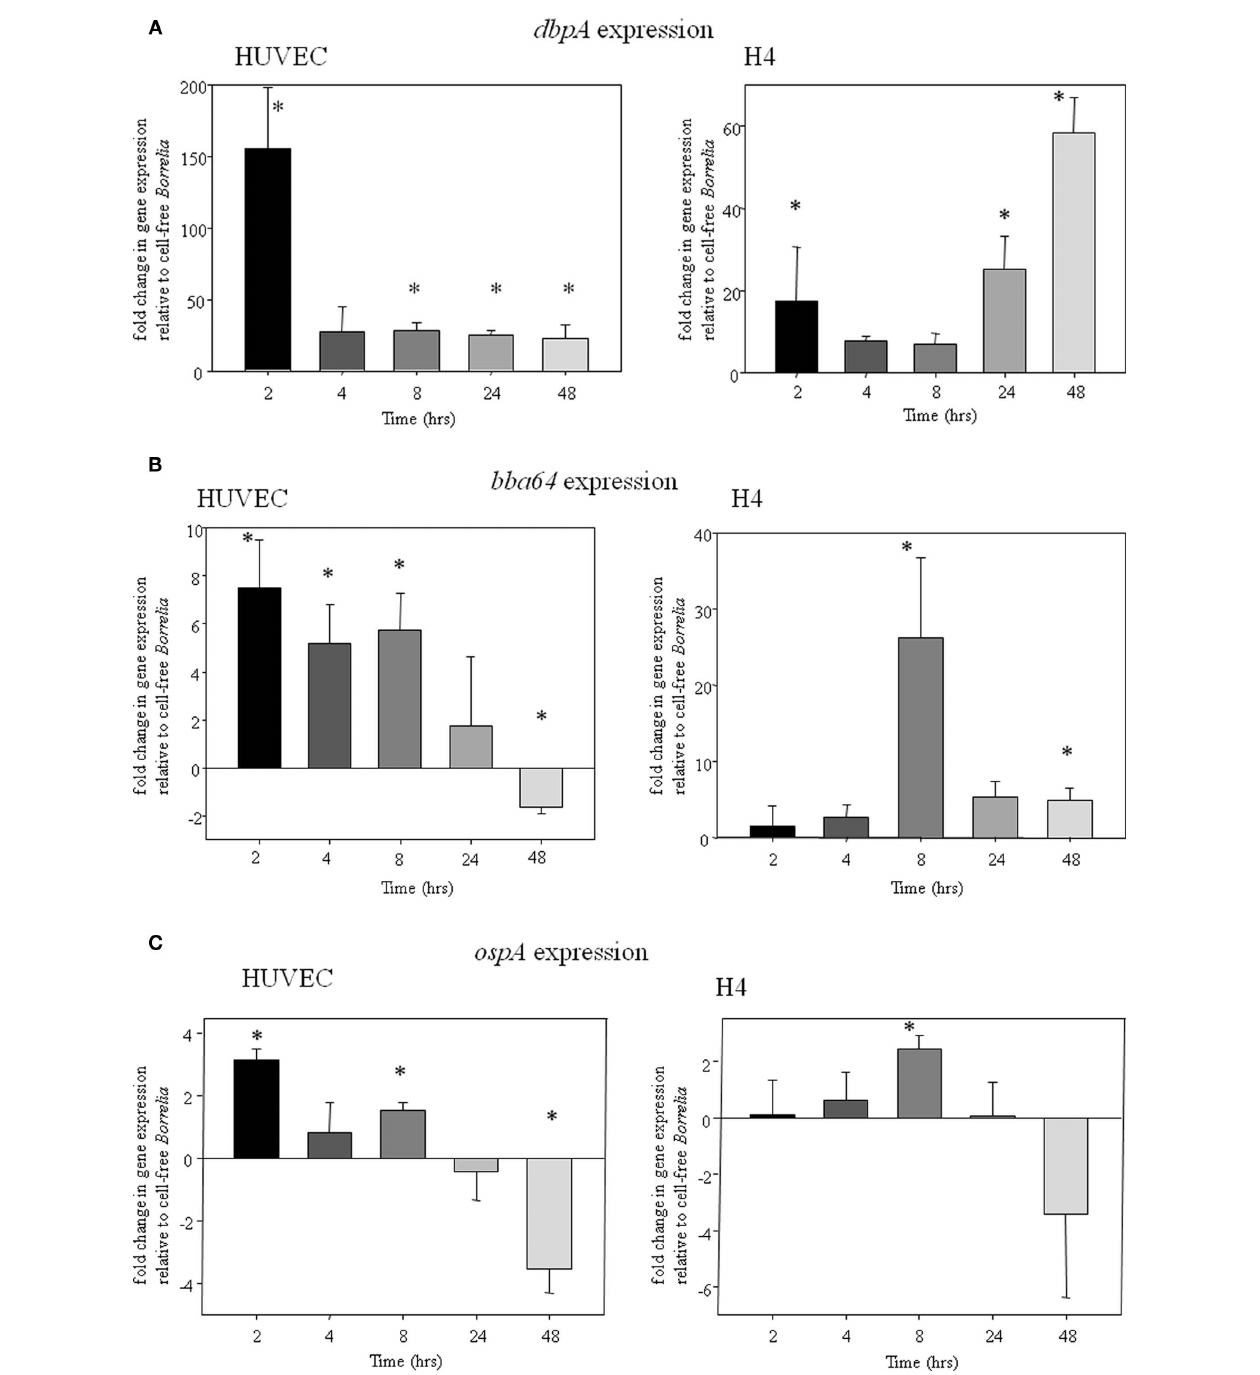
FIGURE 3 | (A) dbpA gene expression in HUVEC (left graph) and H4 cells (right graph); (B) bba64 gene expression in HUVEC (left graph) and H4 cells (right graph); (C) ospA gene expression in HUVEC (left graph) and H4 (right graph).